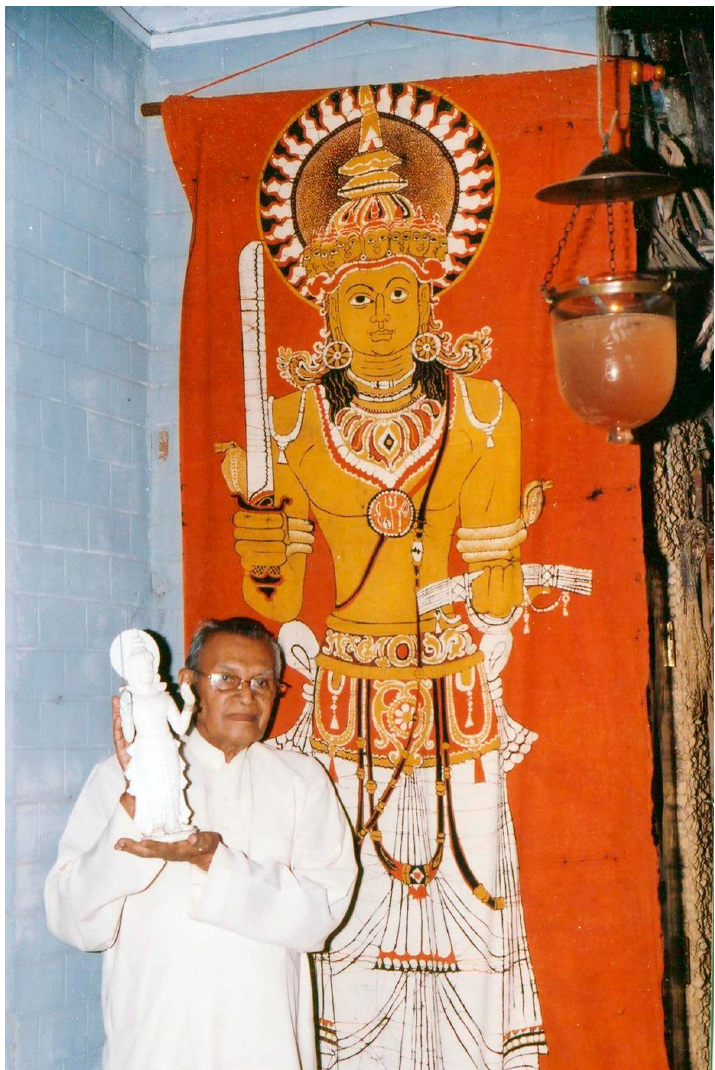
Figure 4. Picture originally taken in the eighties of Arisen Ahubudu with the Ravana banner and statue. This picture has been retrieved from the Official website of A. Ahubudu (n.d.).